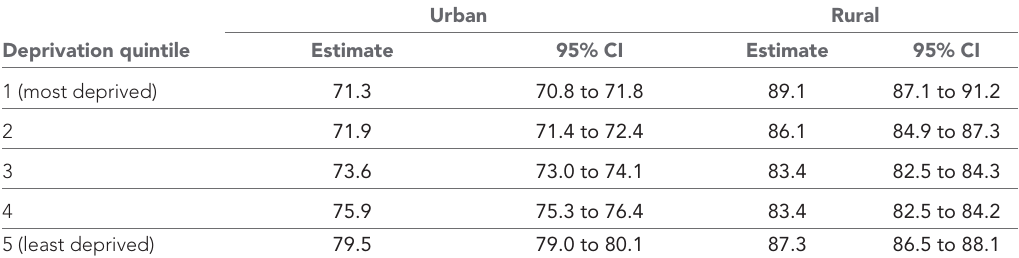
Table 1 Mean percentage of residents in each Lower layer Super Output Area (LSOA) registered to a GP practice within the primary are network (PCN) catchment by urban or rural status and